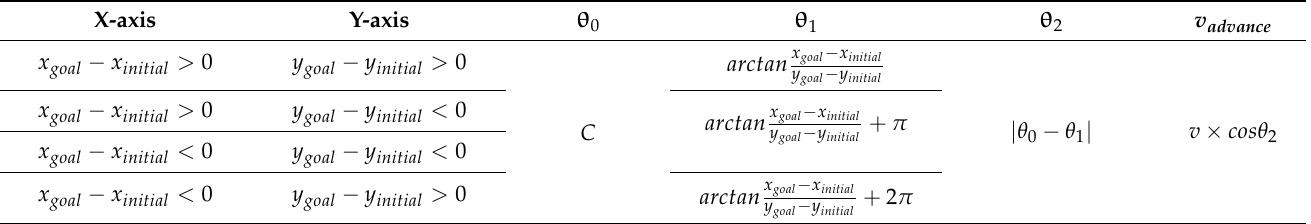
Figure A1. The projection of the velocity in the forward direction. Table A1. The calculation of v advance